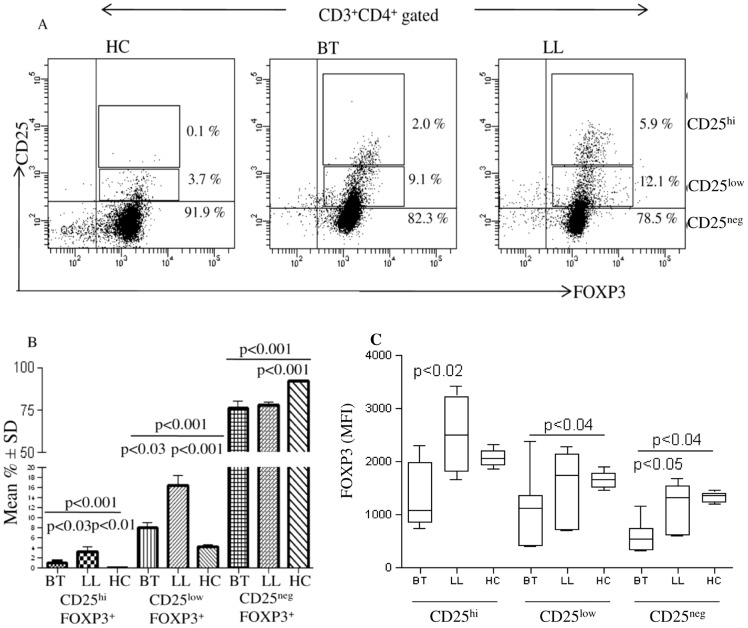
CD25hi and CD25low FOXP3+ iTreg cells show increase in lepromatous leprosy.
A. Florescence intensity of CD25 was graded as high (hi) low and negative (neg) in CD3+CD4+ gated FOXP3+ cells. Representative flow cytometry analysis on 8 each of tuberculoid and lepromatous and 7 healthy subjects is shown in B where increase in percentage of CD25hi was observed in M. leprae stimulated PBMC of lepromatous leprosy as compared to other clinical groups. C. Mean fluorescence intensity (MFI) of FOXP3 in the CD25 hi, CD25 low and CD 25neg populations in the 3 clinical groups clinical groups but not. Abbreviations and p values as in legends to Figures 2 and 3.